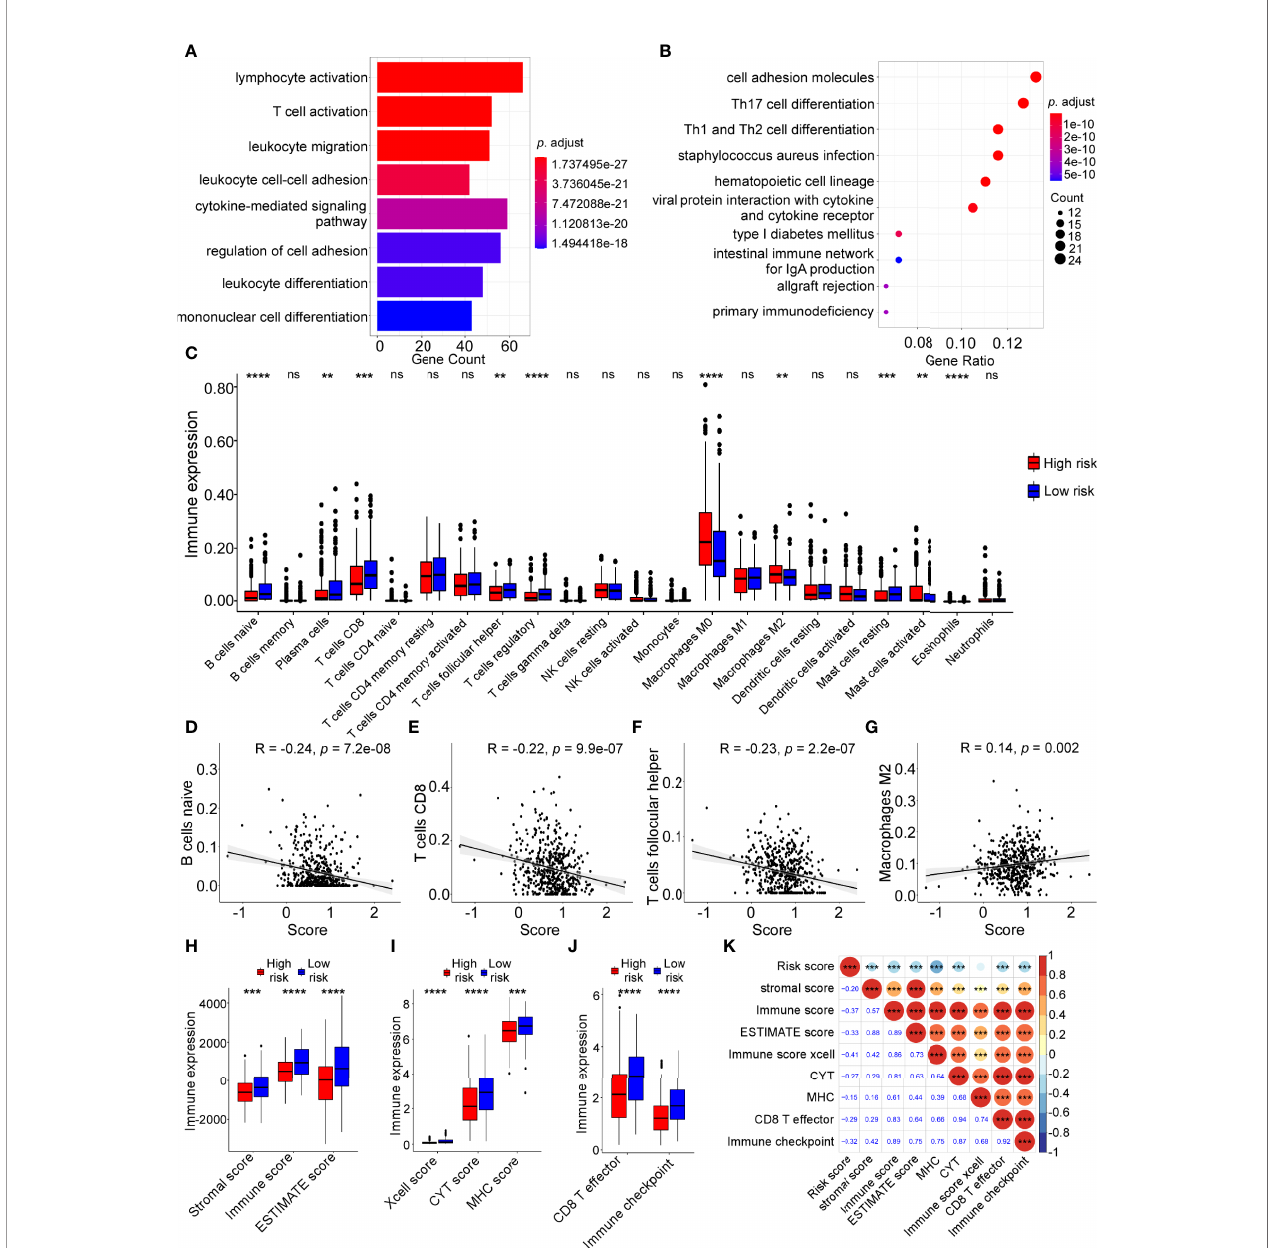
FIGURE 6 | Tumor immune features and immune cell in fi ltration analyses in high-risk and low-risk groups. Gene ontology (GO) (A) and Kyoto Encyclopaedia of Genes and Genomes (KEGG) pathway (B) analyses were performed on dysregulated genes in different risk groups. (C) The in fi ltration levels of 22 immune cells in high-risk and low-risk groups calculated by The Cell-type Identi fi cation by Estimating Relative Subsets of RNA Transcripts (CIBERSORT) analysis (Wilcoxon test, ns: not signi fi cant; **P < 0.01; ***P < 0.001; ***P < 0.0001). (D – G) Linear correlation between risk score and naive B cell in fi ltration levels (D) , CD8 T cell in fi ltration levels (E) , follicular helper T cell in fi ltration levels (F) , M2 macrophage cell in fi ltration (G) . (H) Boxplot of ESTIMATE score in high and low risk groups (Wilcoxon test, ***P < 0.001; ***P < 0.0001). (I) Boxplot of xCell-immune score, CYT score, MHC score in high and low risk groups (Wilcoxon test, ***P < 0.001; ***P < 0.0001). (J) Boxplot of the score of CD8 T effector and immune checkpoint in high and low risk groups (Wilcoxon test, ***P < 0.0001). (K) Correlation of risk score with other immune features by Pearson correlation